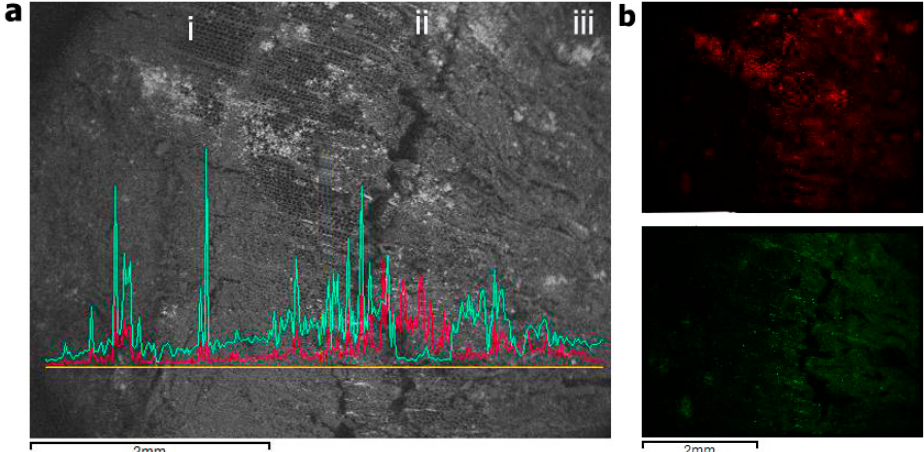
Figure 2. EDS line ‐ scan and mapping of a sample where all conditions coexisted. ( a ) Line scan of Fe (red) and S (green) (left to right the transition from charred to uncharred, i–iii); ( b ) mapping of Fe (red) and S (green).